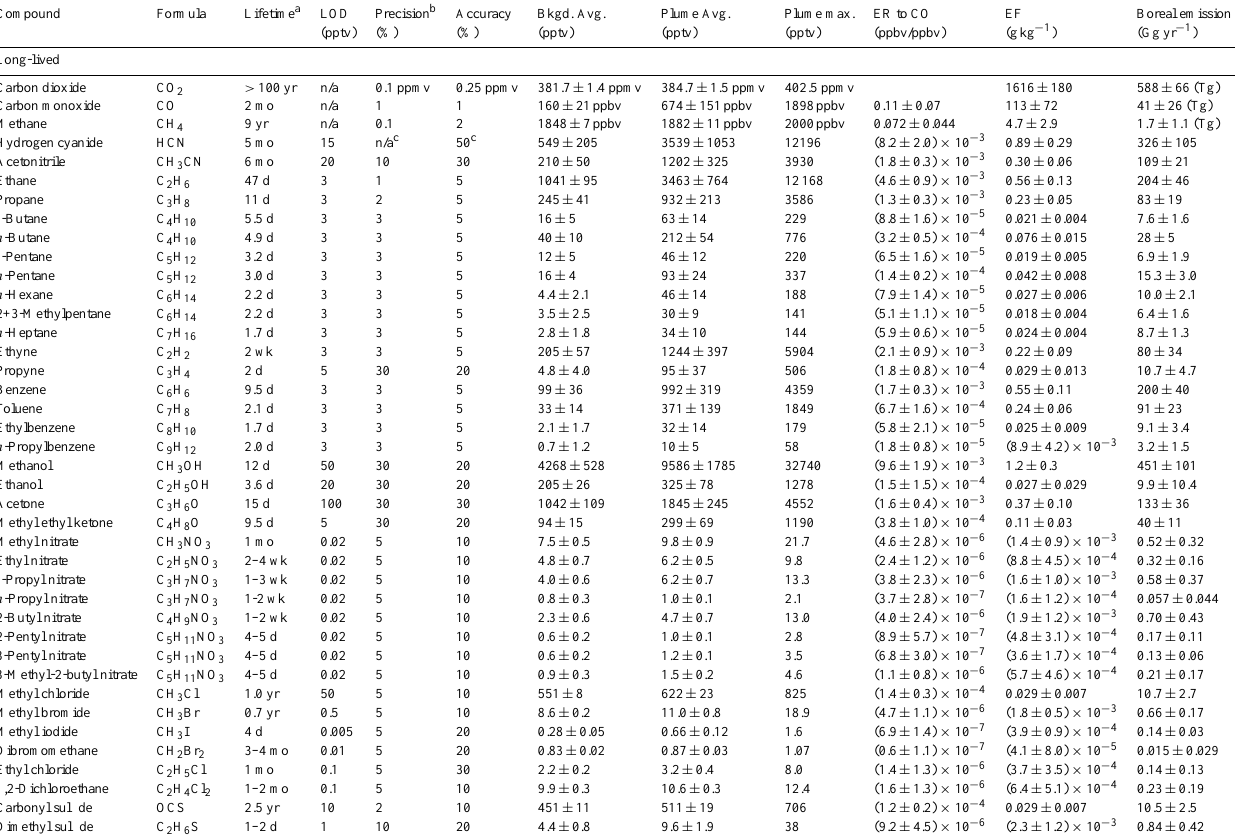
Table 1. Analytical details, measurement statistics, emission ratios (ERs) and emission factors (EFs) for CO 2 , CO, CH 4 , NO, NO 2 , HCN, CH 3 CN and 57 NMVOCs that were statistically enhanced in five Canadian boreal forest fire plumes compared to background measurements during the summer 2008 ARCTAS field mission. For both long-lived and short-lived compounds, “Plume avg.” is the average mixing ratio calculated from the five smoke plume averages; “Bkgd. avg.” is the average of the five corresponding background air masses; and “Plume max.” is the maximum mixing ratio measured in all five smoke plumes. However the ERs and EFs presented here for the short-lived compounds are based on a much smaller subset of data (see text). The CO ER uses CO 2 as its reference